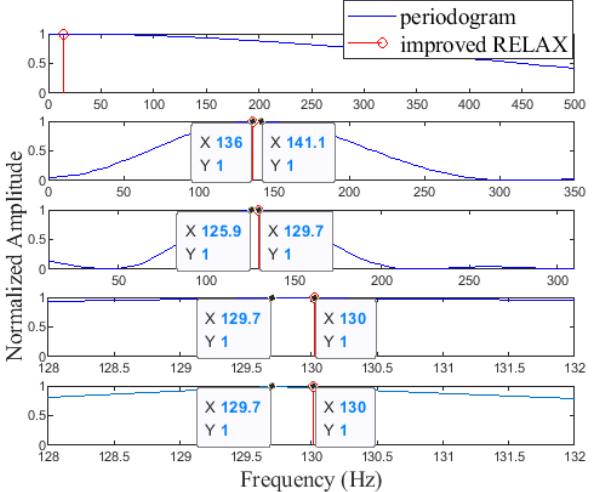
Figure 9. The estimated results of the periodogram and the improved algorithm at five different durations, where thebule line and the red line represent the estimated results of periodogram and improved algorithm, respectively. Table 4. Estimation error (transmitted frequency: 130